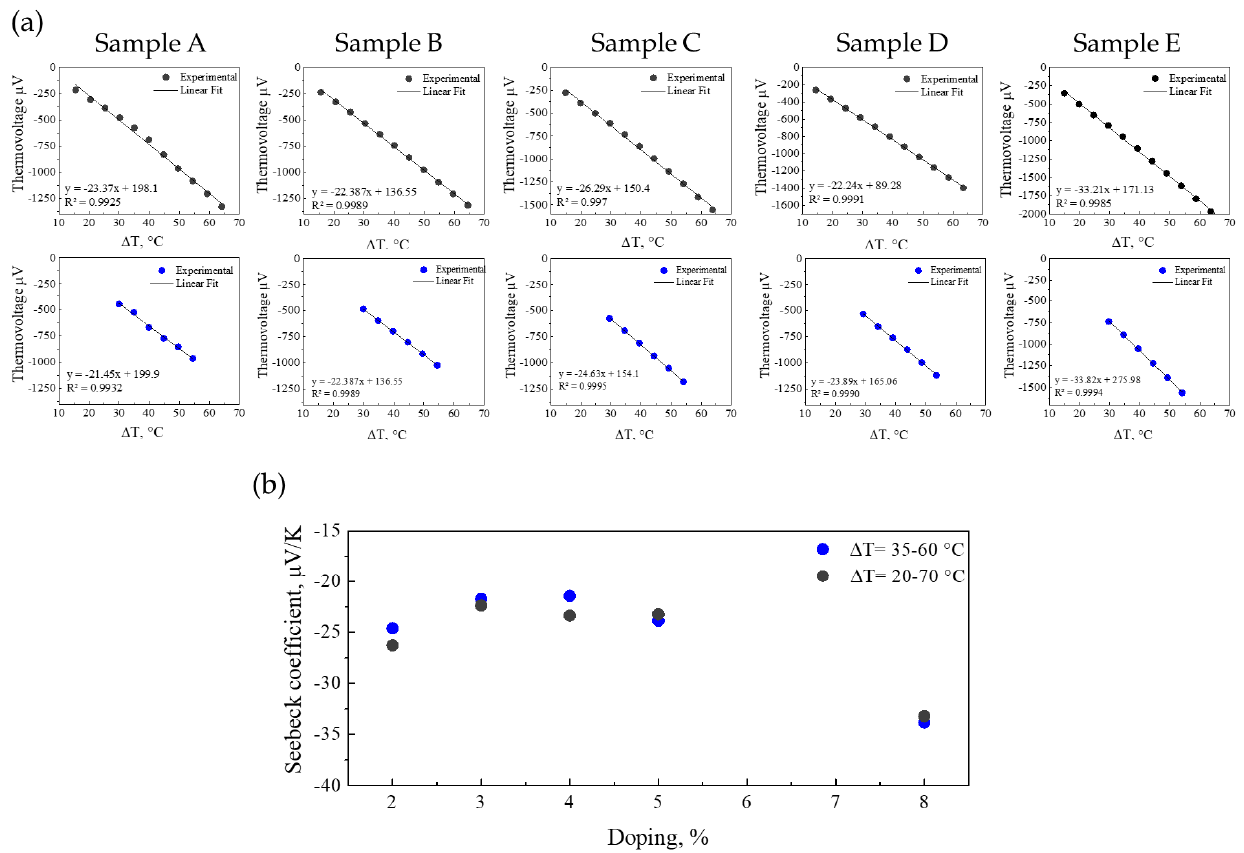
Figure 7. ( a ) Thermovoltage plotted against the applied thermal gradients in the range of 15–70 ◦ C (top graph) and in the range of 30–60 ◦ C (bottom graph). The plots show both the experimental data and the linear fit. The slope of the fit represents the Seebeck coefficient, reported in panel ( b